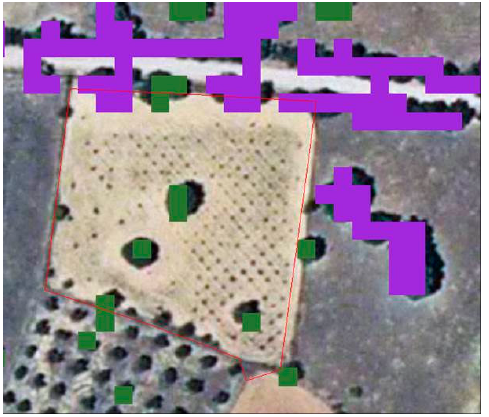
Figure 12. Detection of copses (in purple) and isolated trees (in green) around woody crop areas.